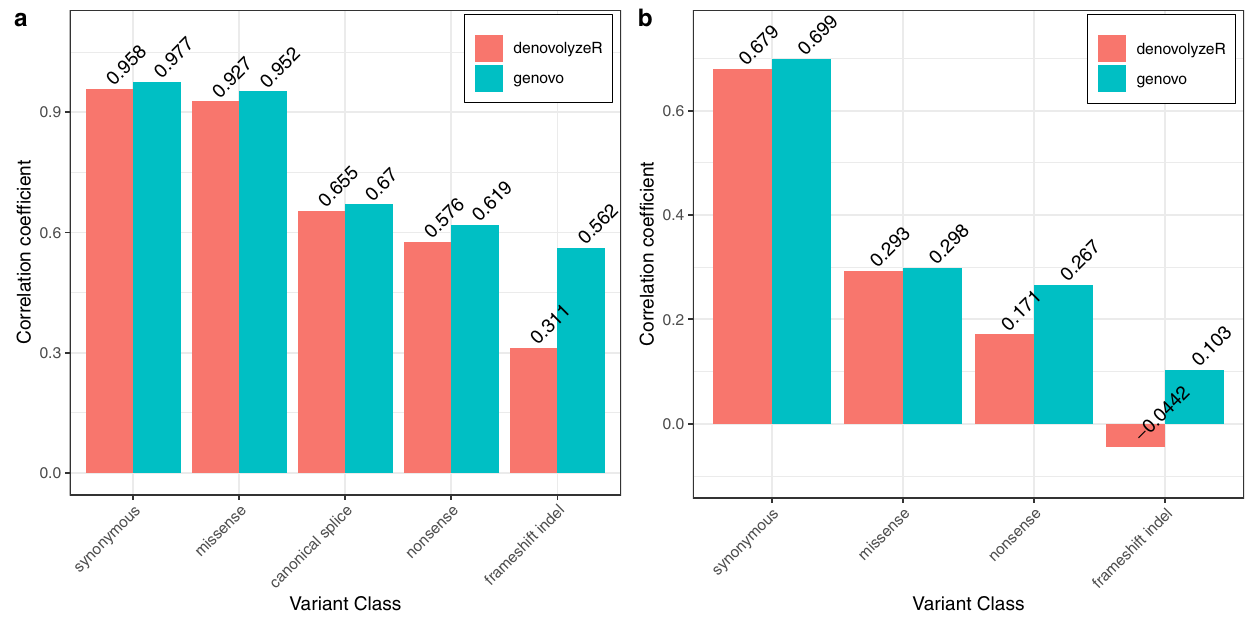
Fig. 5 | Correlation between the predicted genic rate for a mutation type and the number of segregating variants of that type. a Pearson correlation coef fi - cient between the observed number of mutations per gene and the expected